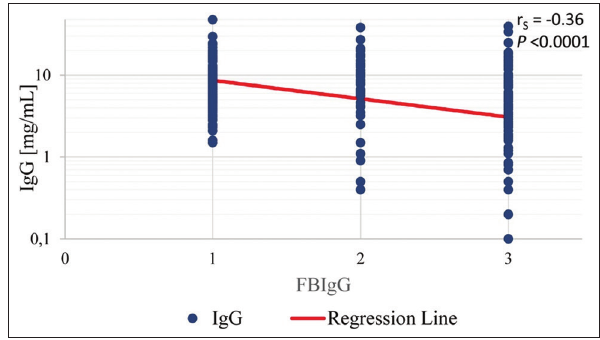
Figure-1: Correlation between the FB-immunoglobulin G (IgG) and ELISA-IgG concentration determinations. The equation for the regression line is: ELISA- IgG=10 (1.16 - 0.224 FB-IgG) . IgG concentrations of calves that were sufficiently supplied with colostral antibodies are shown on the left (score 1, serum IgG concentration >10 mg/mL). Partial FPT with serum IgG concentration of 5–10 mg/mL was defined as a score of 2, and a complete FPT with serum IgG concentrations <5 mg/mL was scored with a value of 3, on the right of the Table-1: Results of the FB-IgG and ELISA-IgG assays in calves (up to 10 days of age). ELISA-IgG (gold standard/reference test) (n/%) FB-IgG (n/%) 113/61.1 True positive (sensitivity)